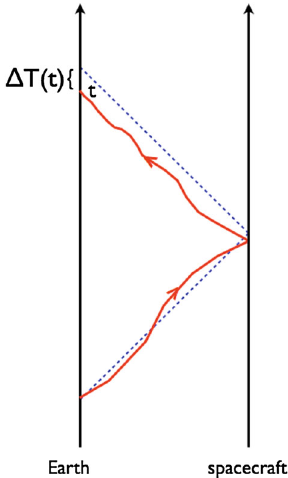
Fig. 21 A spacetime diagram representation of Δ T ( t ) for a two-way spacecraft Doppler tracking measurement. Time increases vertically upward. The vertical arrows are spacetime worldlines for the Earth and a spacecraft. The measurement is made at time t . The blue dotted line shows the trajectory of a pulse of electromagnetic radiation in the absence of a gravitational wave; the red solid line shows the trajectory in the presence of a gravitational